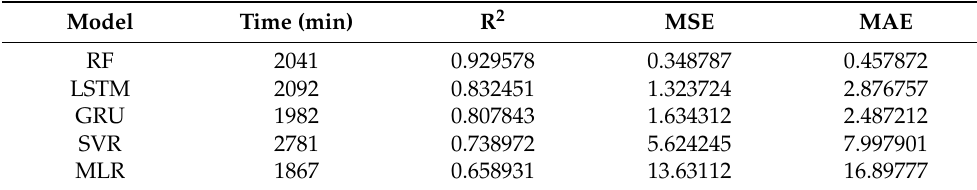
Table 12. Evaluation results of regression